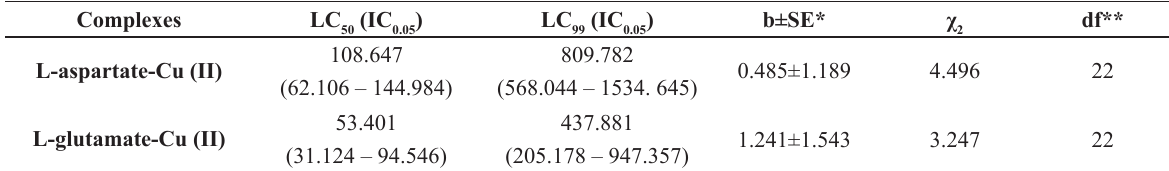
L-glutamate-Cu (II) obtained with the mortality of Ae. aegypti